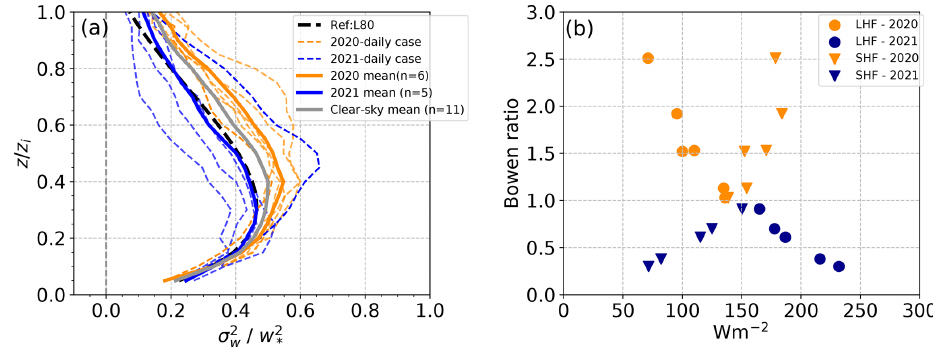
Figure 10. (a) σ 2 w /w 2 ∗ profiles averaged from 10:00–15:00UTC by individual days in the clear-sky category and (b) surface sensible heat flux (triangle) and surface latent heat flux (circle) for the 2020 (orange) and the 2021 (blue) datasets.